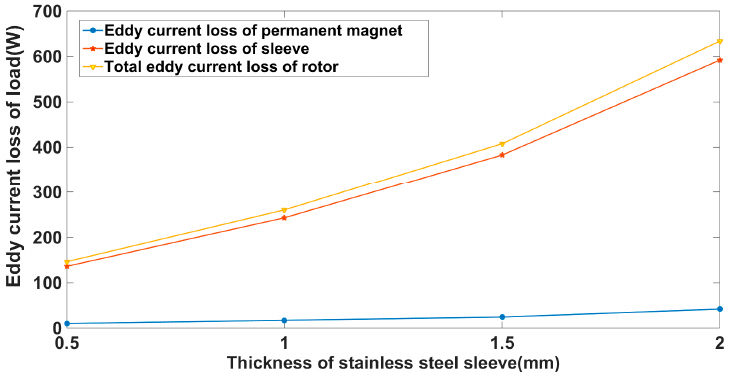
Figure 10. The eddy current loss of a jacket with different thicknesses under a given load condition.